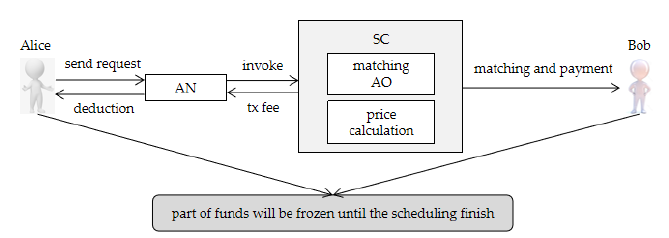
Figure 7. Payment Figure 7. Payment process.